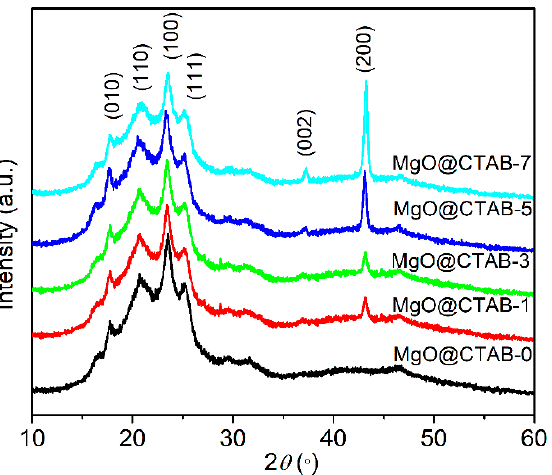
Figure 5. XRD patterns of PBAT nanocomposites with different loadings of MgO@CTAB.